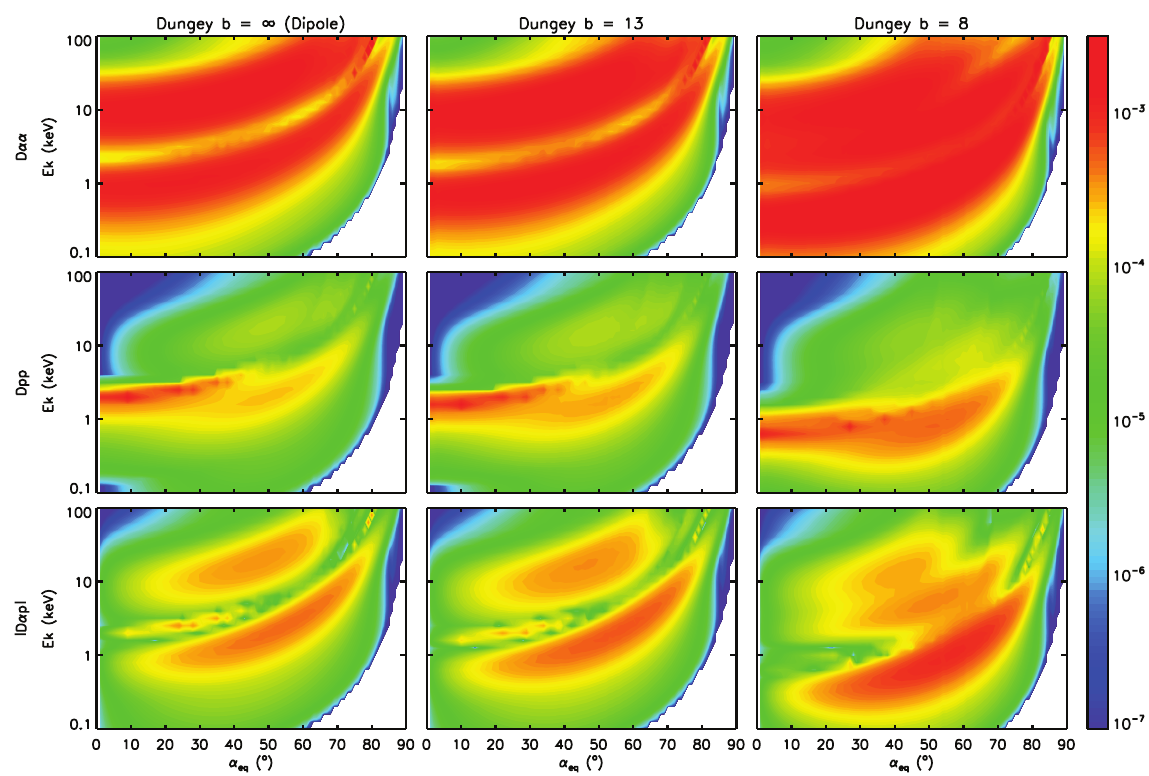
Fig. 2. Bounce-averaged pitch angle diffusion (top), energy diffusion (middle), and mixed diffusion (bottom) coefficients (in units of s − 1 ) corresponding to use of the Dungey magnetic models with b =∞ (dipole), 13, and 8 at the equatorial crossing of L =